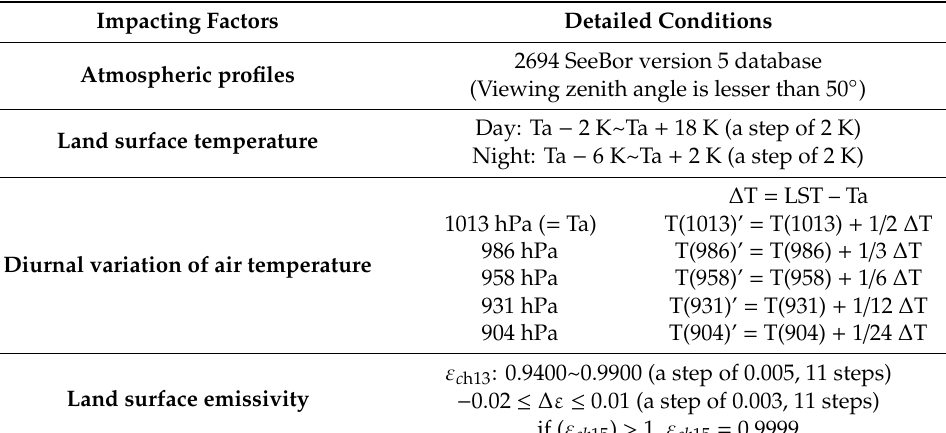
Table 2. The input conditions of the radiative transfer model simulation according to the various atmospheric and surface